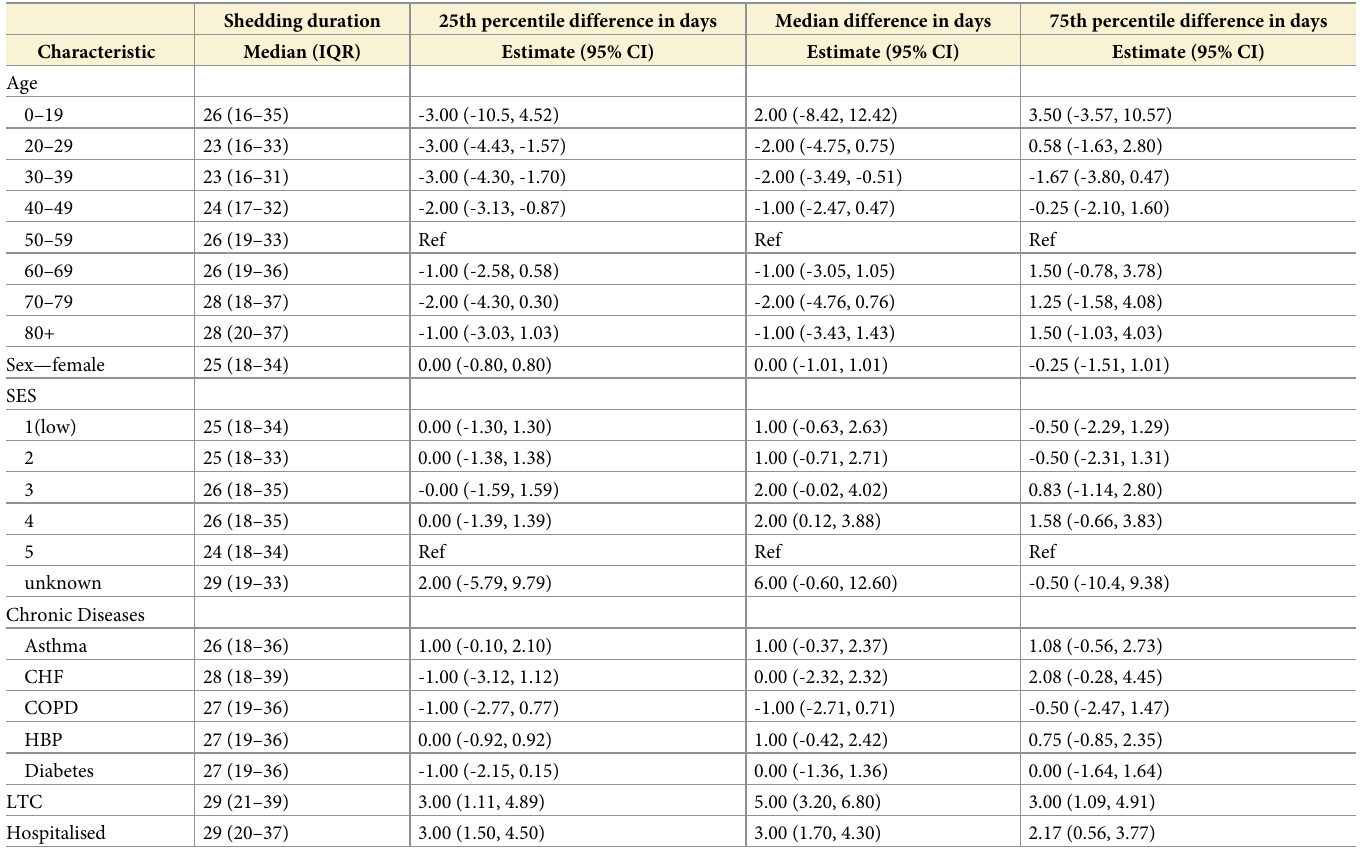
Table 4. Multivariable quantile regression results on factors associated with documented resolution duration (N = 3,219). Shedding